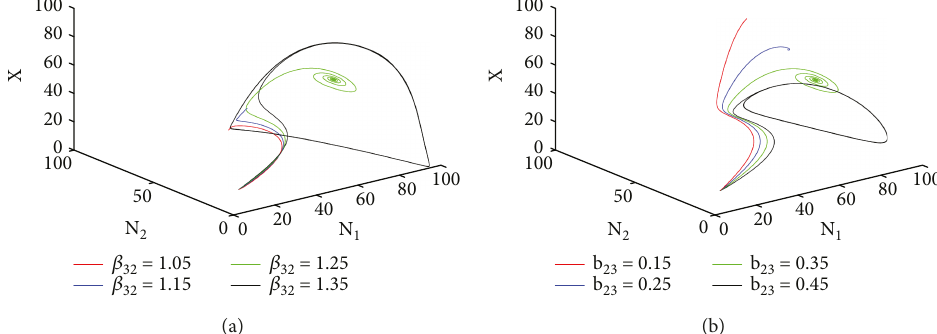
32 and (b) b 23 . The rest of the parameters is taken as given in